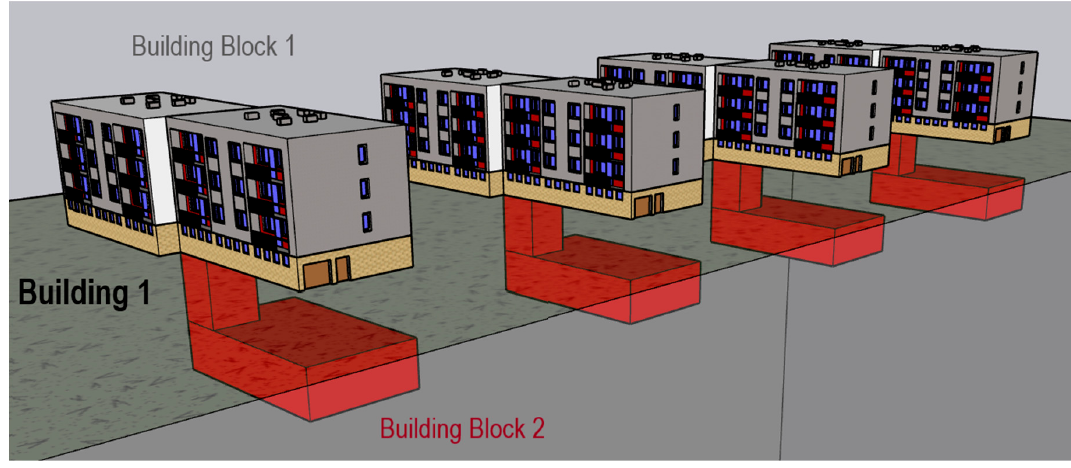
Figure 11. Access to the underground object from only one building. Source: own study.